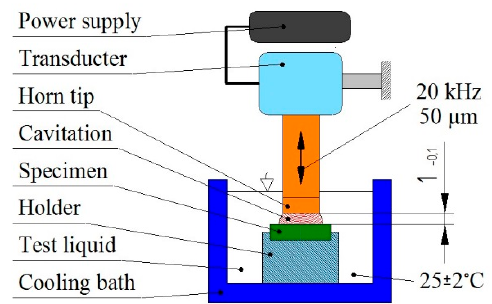
Figure 1. Design of a vibratory apparatus for cavitation tests.